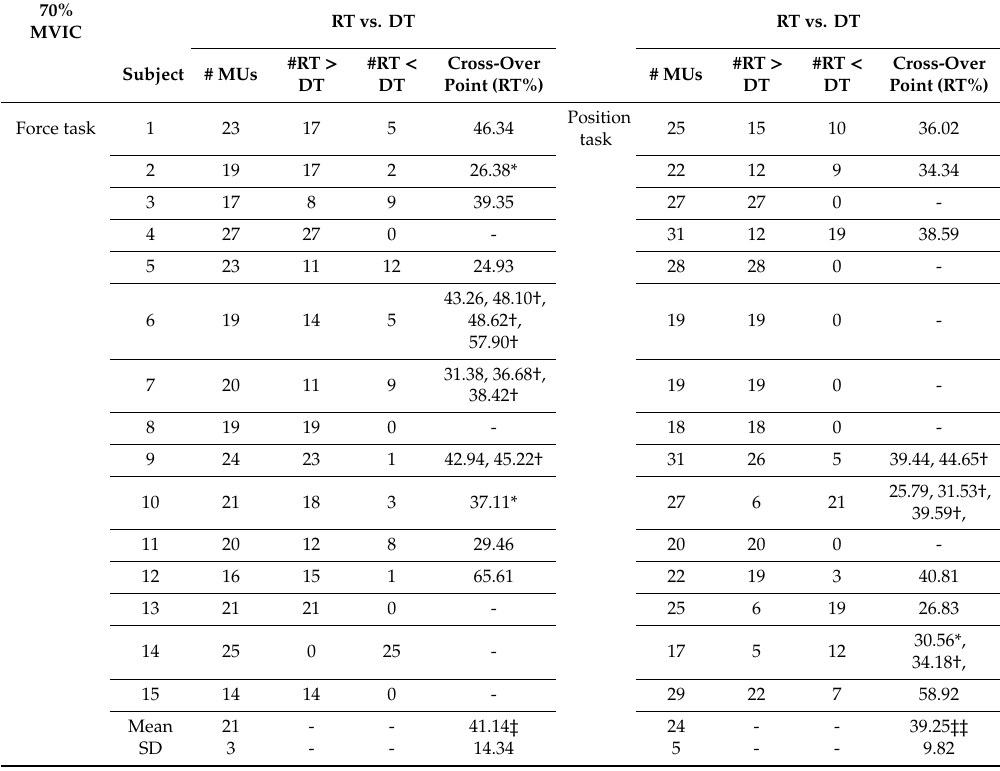
Table 2. The number of motor units, the number of motor units with recruitment threshold (RT) < derecruitment threshold (DT) and RT > DT, and cross-over point (RT%) of the motor unit RT and DT relationship for force and position tasks at 70% maximal voluntary isometric contraction (MVIC) contraction intensities. 70% RT vs. MVIC